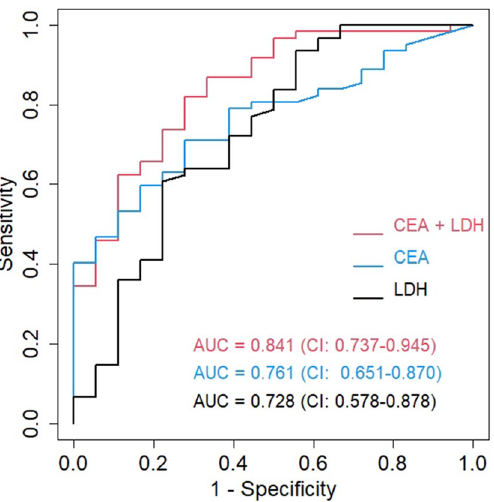
Figure 1. Receiver operating characteristic (ROC) curves for the prediction of MPE.